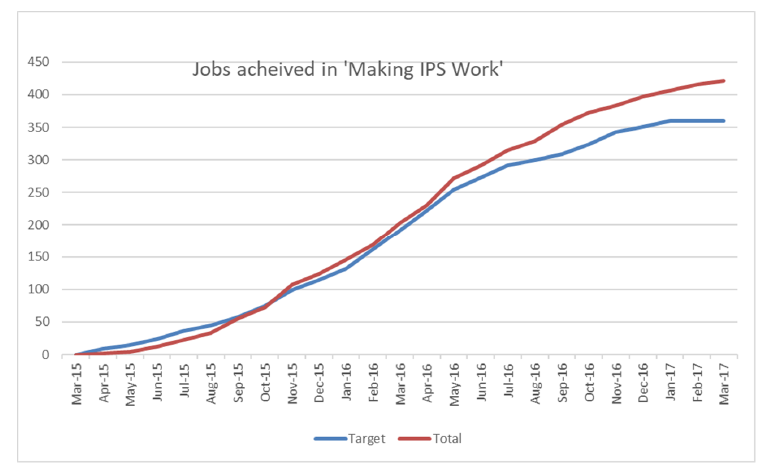
Figure 2. Jobs achieved in all sites.